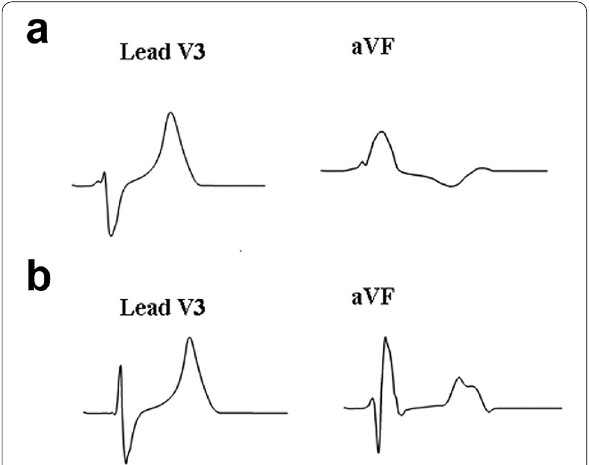
Fig. 4 Computed ECG in the patient in the LBBB ( a ) and CRT pacing ( b ) conditions. CRT cardiac resynchronization therapy, = ECG electrocardiogram, LBBB left bundle branch = =